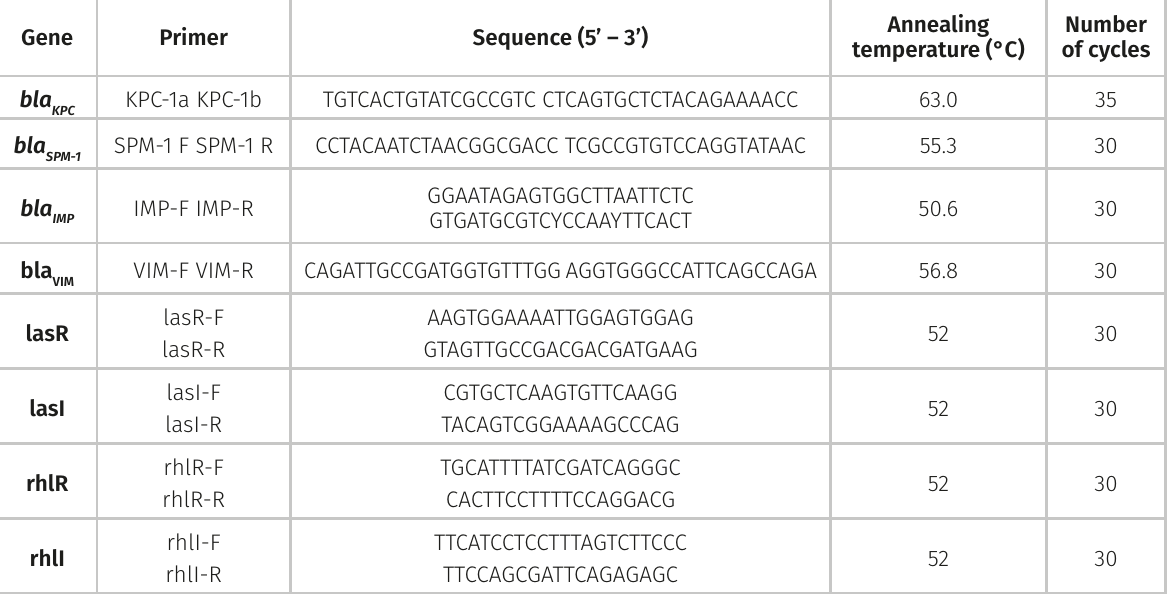
Table I. Primers used in the detection of β-lactamases and QS genes.